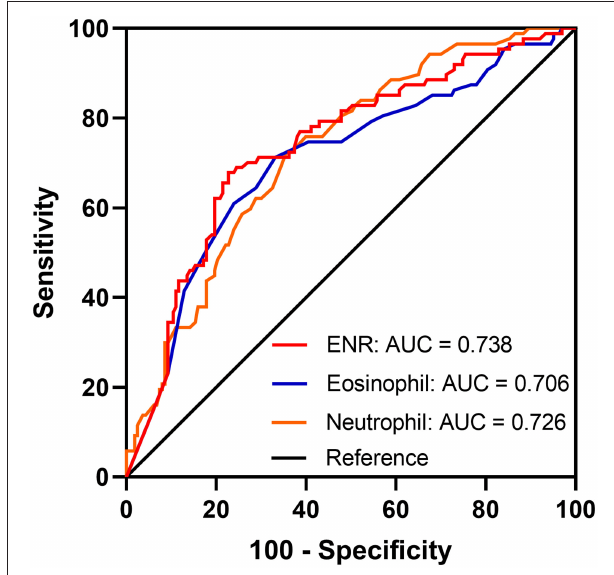
FIGURE 2 | Receiver operator characteristic curves for the prediction of 3-month poor outcome using neutrophil, eosinophil, and eosinophil-to-neutrophil ratio (ENR).